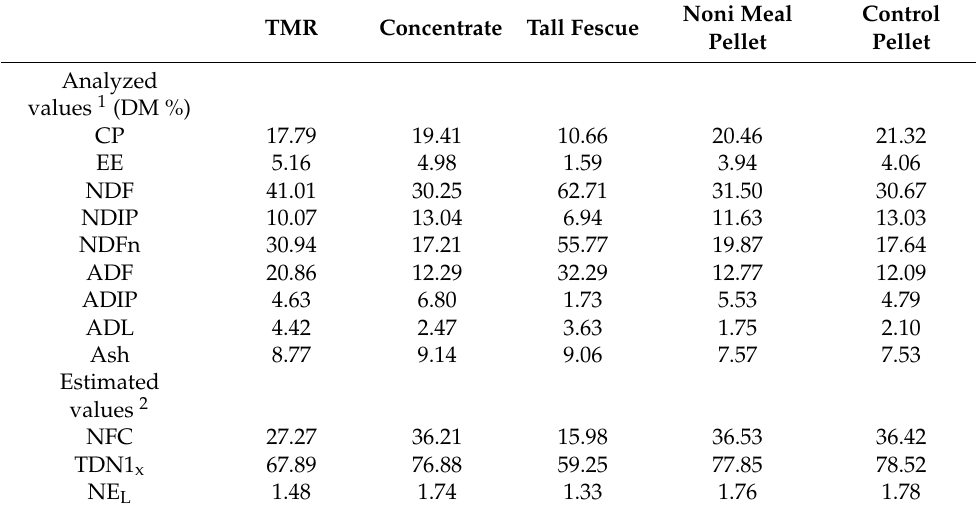
Table 3. Chemical compositions of